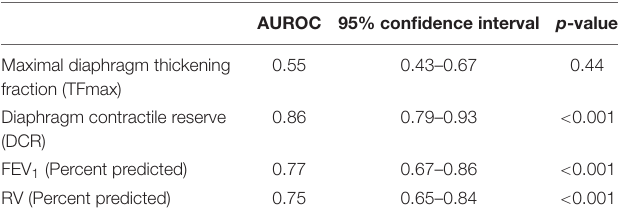
TABLE 5 | ROC analysis comparing ultrasonographic and lung function variables in the identification of patients with higher dyspnea scores (mMRC >